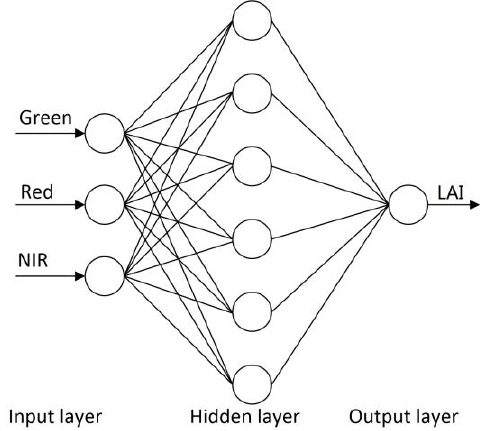
Figure 4. The architecture of the back propagation neural networks (BPNNs) used for LAI estimation from GF-1 WFV reflectance data.